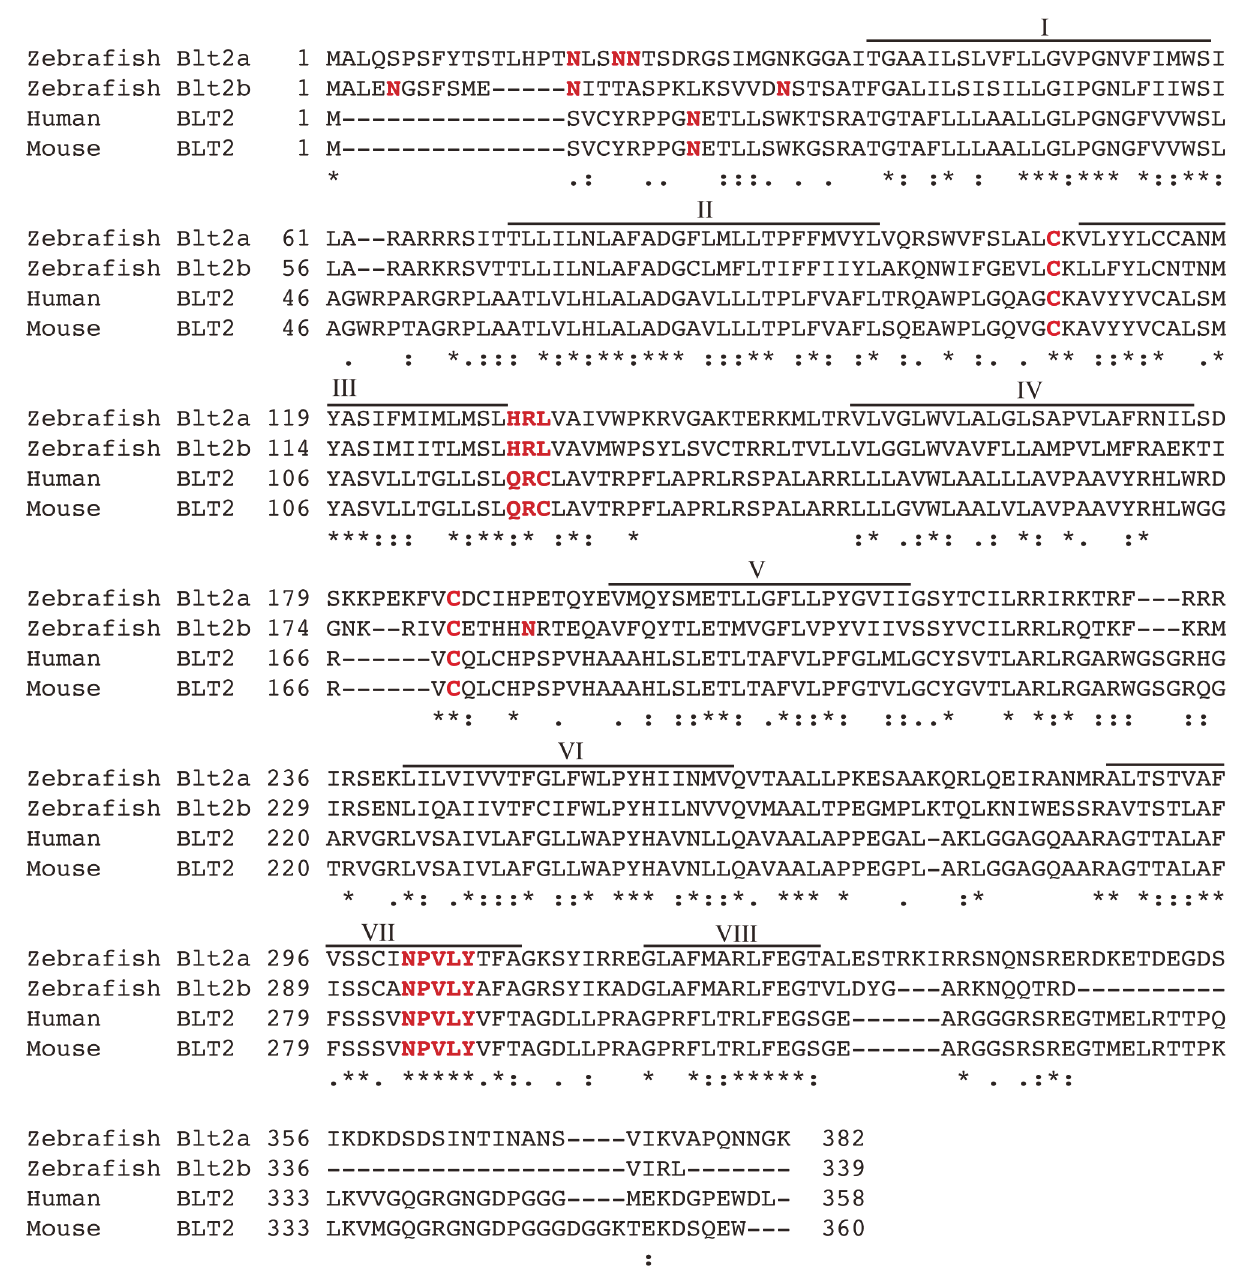
Fig 2. Sequence alignment of zebrafish Blt2a and Blt2b with human and mouse BLT2. The amino acid sequences of zebrafish Blt2 and human and mouse BLT2 were aligned using MAFFT (http://www.ebi.ac.uk/Tools/msa/mafft/). Identical residues are indicated with asterisks ( * ), highly conserved residues with colons, and semi-conserved residues with periods (.). The predicted glycosylated aspartate, the predicted cysteine residues that form disulfide bonds, and the DRY and N/DPxxY motifs are indicated in red. Putative helical domains that form helix I to helix VIII are indicated above the aligned sequences. The sequences of zebrafish Blt2 are available from EMBL/GenBank/DDBJ under accession nos. LC009450 and